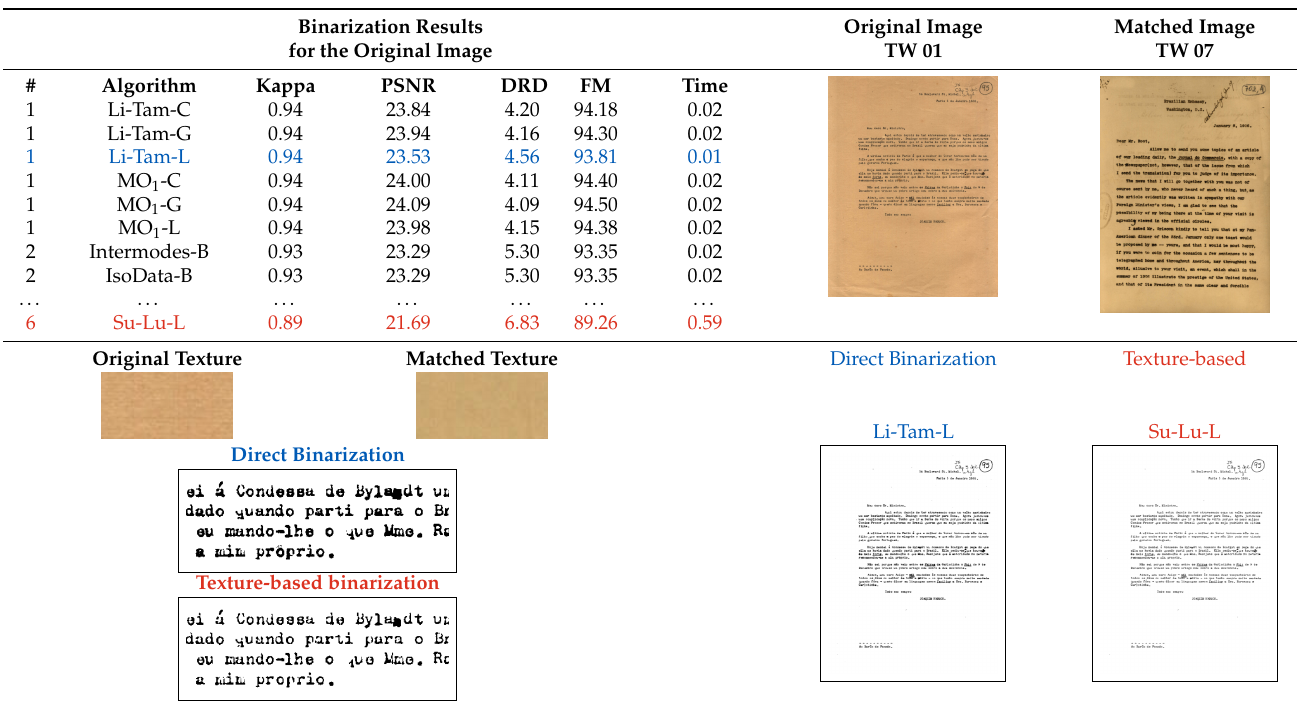
Table 10. Results for image matching with image TW 01.